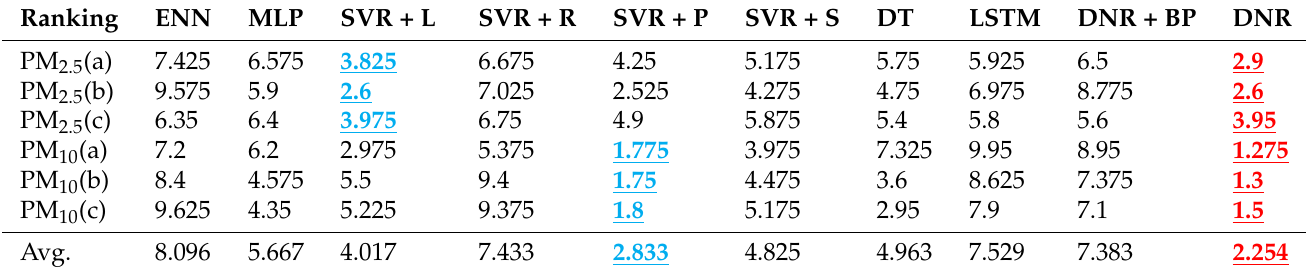
Table 6. Resulting nonparametric statistical Friedman tests of all prediction models, with the best and second-best results highlighted in red and blue, respectively.